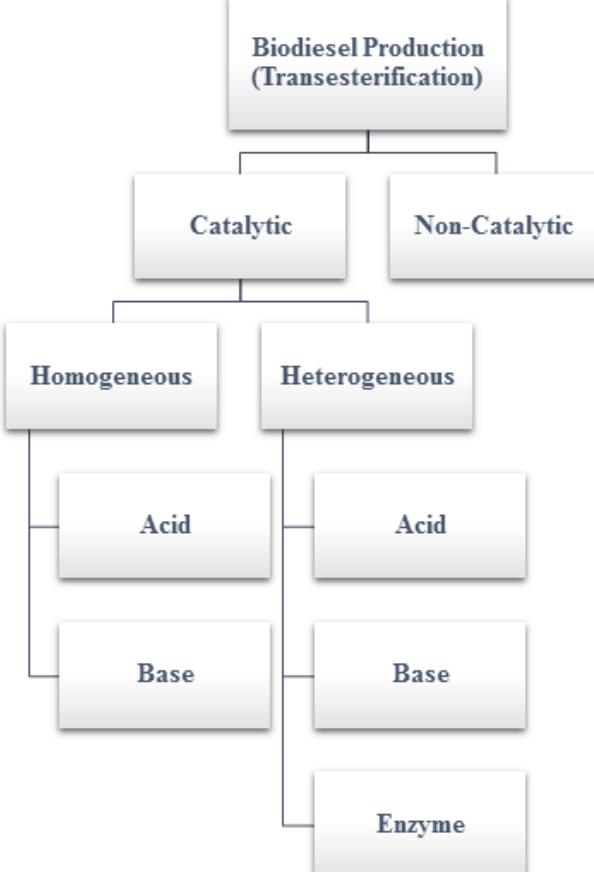
Figure 1. Biodiesel production classification.